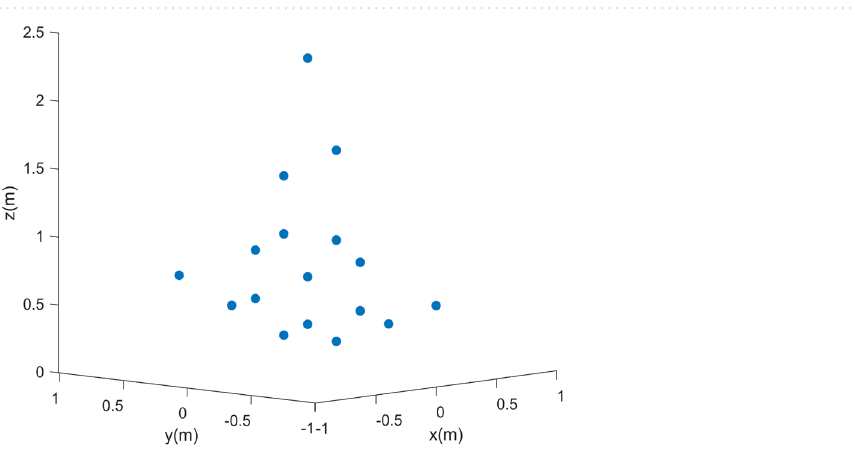
Figure 12. Comparison of two-dimensional imaging of the target. ( a ) Uncompensated 2 ‐ D image. ( b ) The compensated 2 ‐ D image.